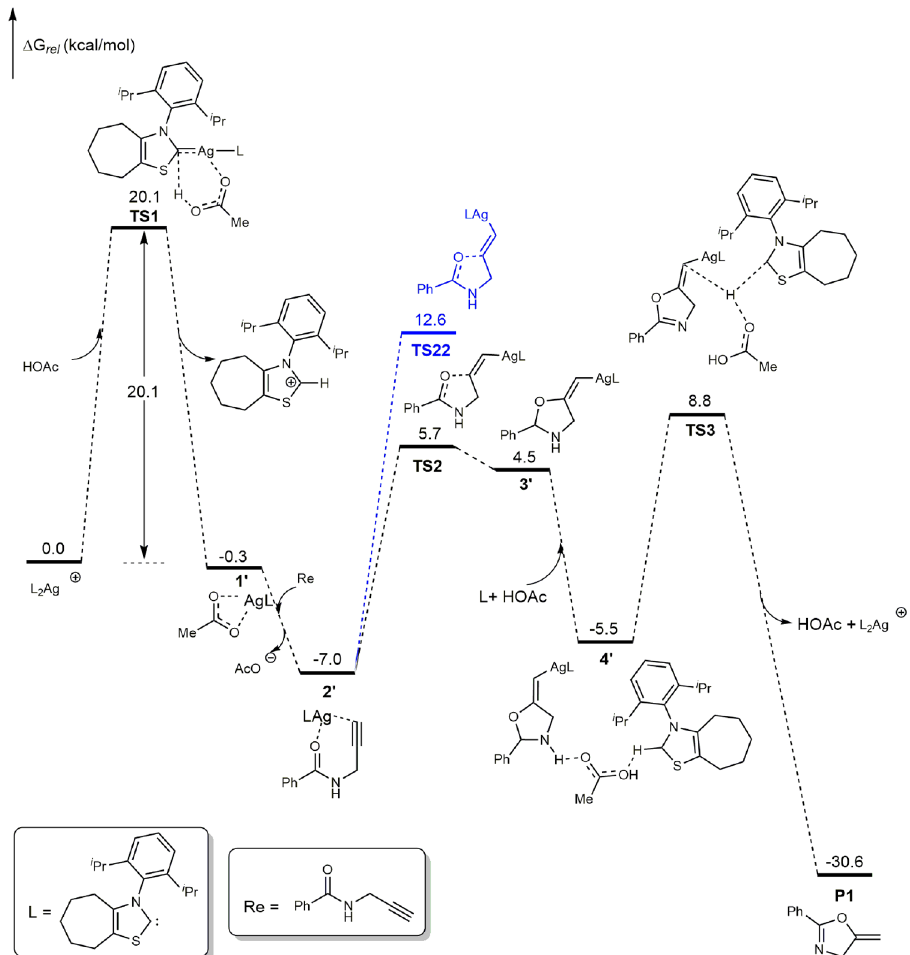
Fig. 9 DFT-computed free energy pro fi le of Ag – NHC catalyzed cyclization of N -propargylic amides. See Supplementary Note 3 for computational